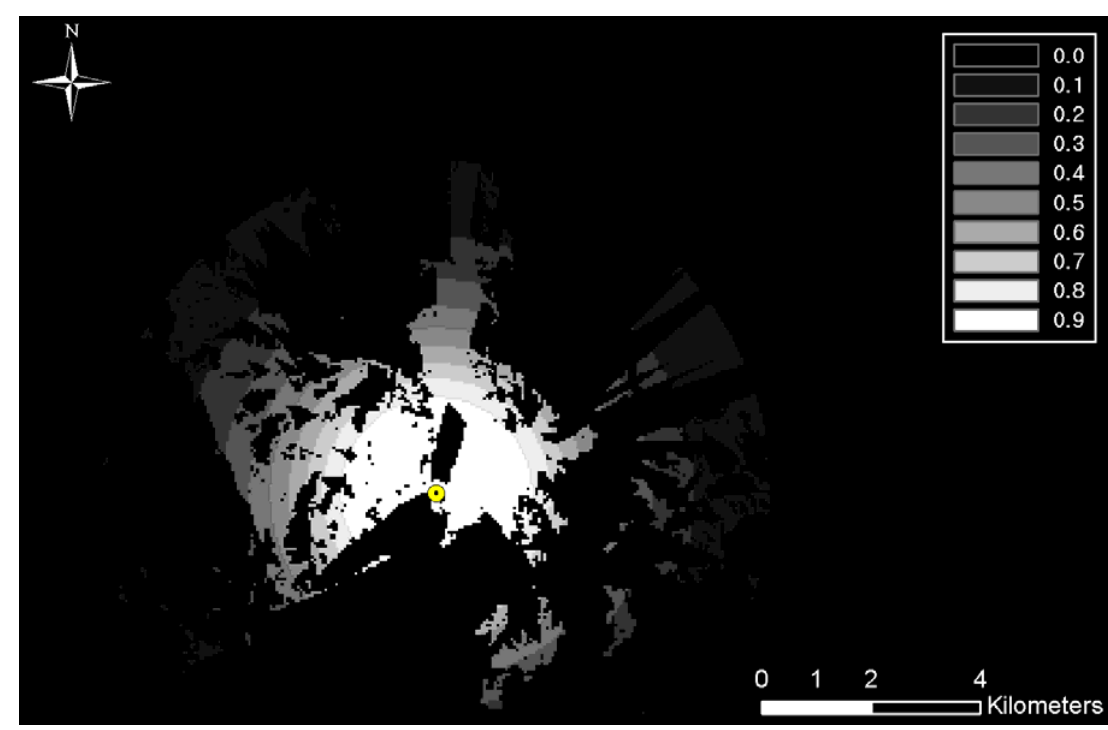
Figure 8. Individual TOD detection probability fused with viewshed